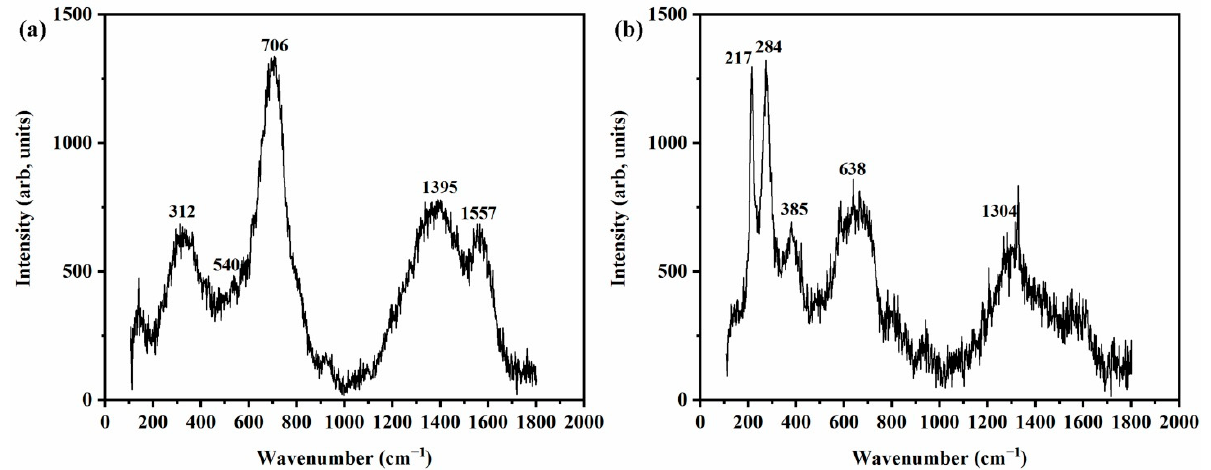
Figure 11. Raman spectra of the corrosion products formed on the surface of hydrogen permeation sensors exposed to the tidal zone ( a ) and the immersion zone ( b ).